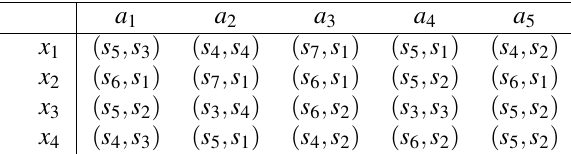
Table 4. Decision matrix R